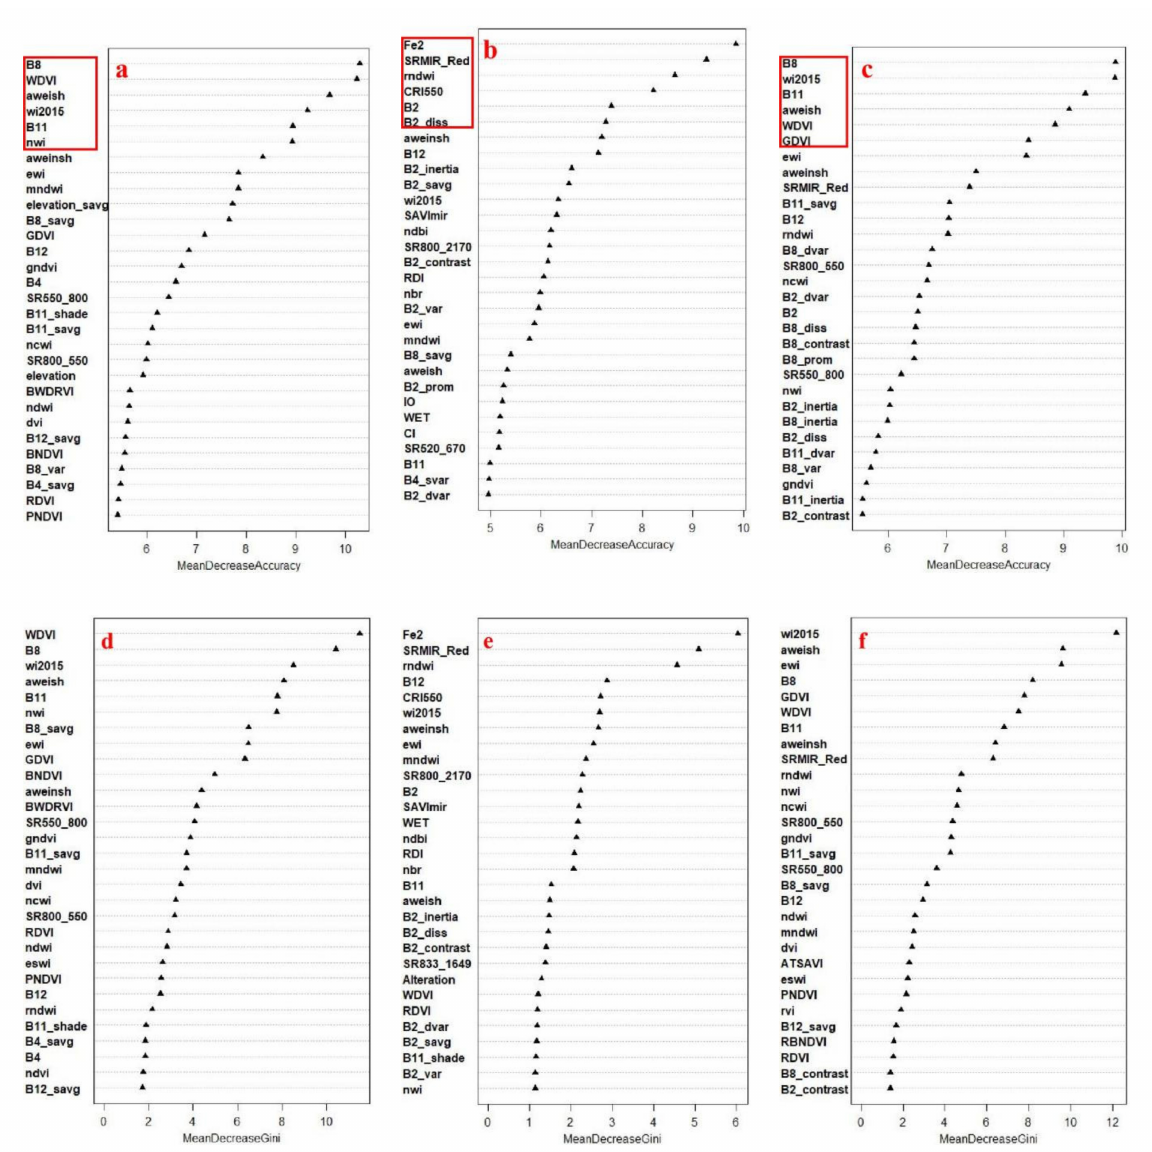
Figure 5. Ranking of the importance of the feature variables in three subregions. ( a – c ) ranking of MDA for the first, second, and third region; ( d – f ) ranking of MDG for the first, second, and third